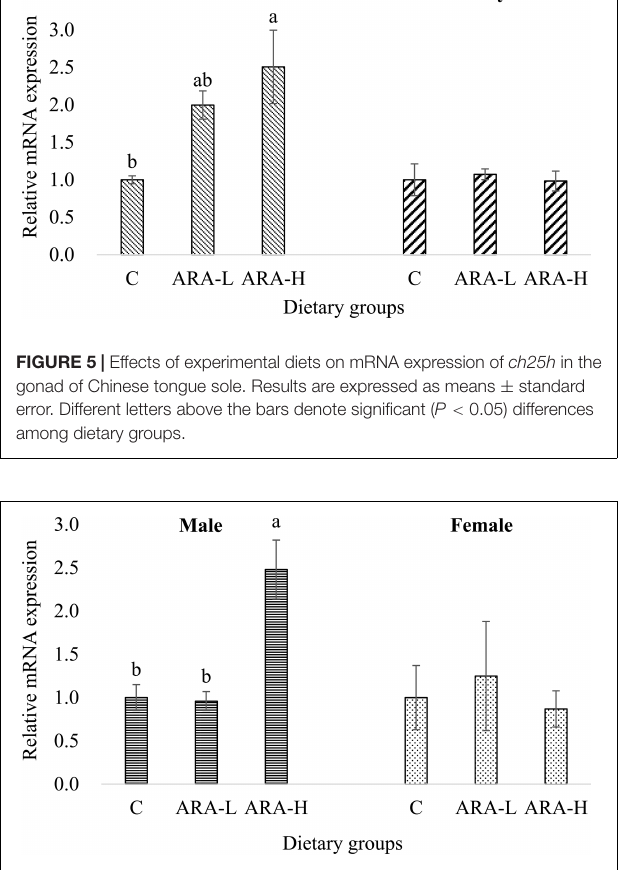
FIGURE 6 | Effects of experimental diets on mRNA expression of ch25h in the brain of Chinese tongue sole. Results are expressed as means ± standard error. Different letters above the bars denote significant ( P < 0.05) differences among dietary groups.